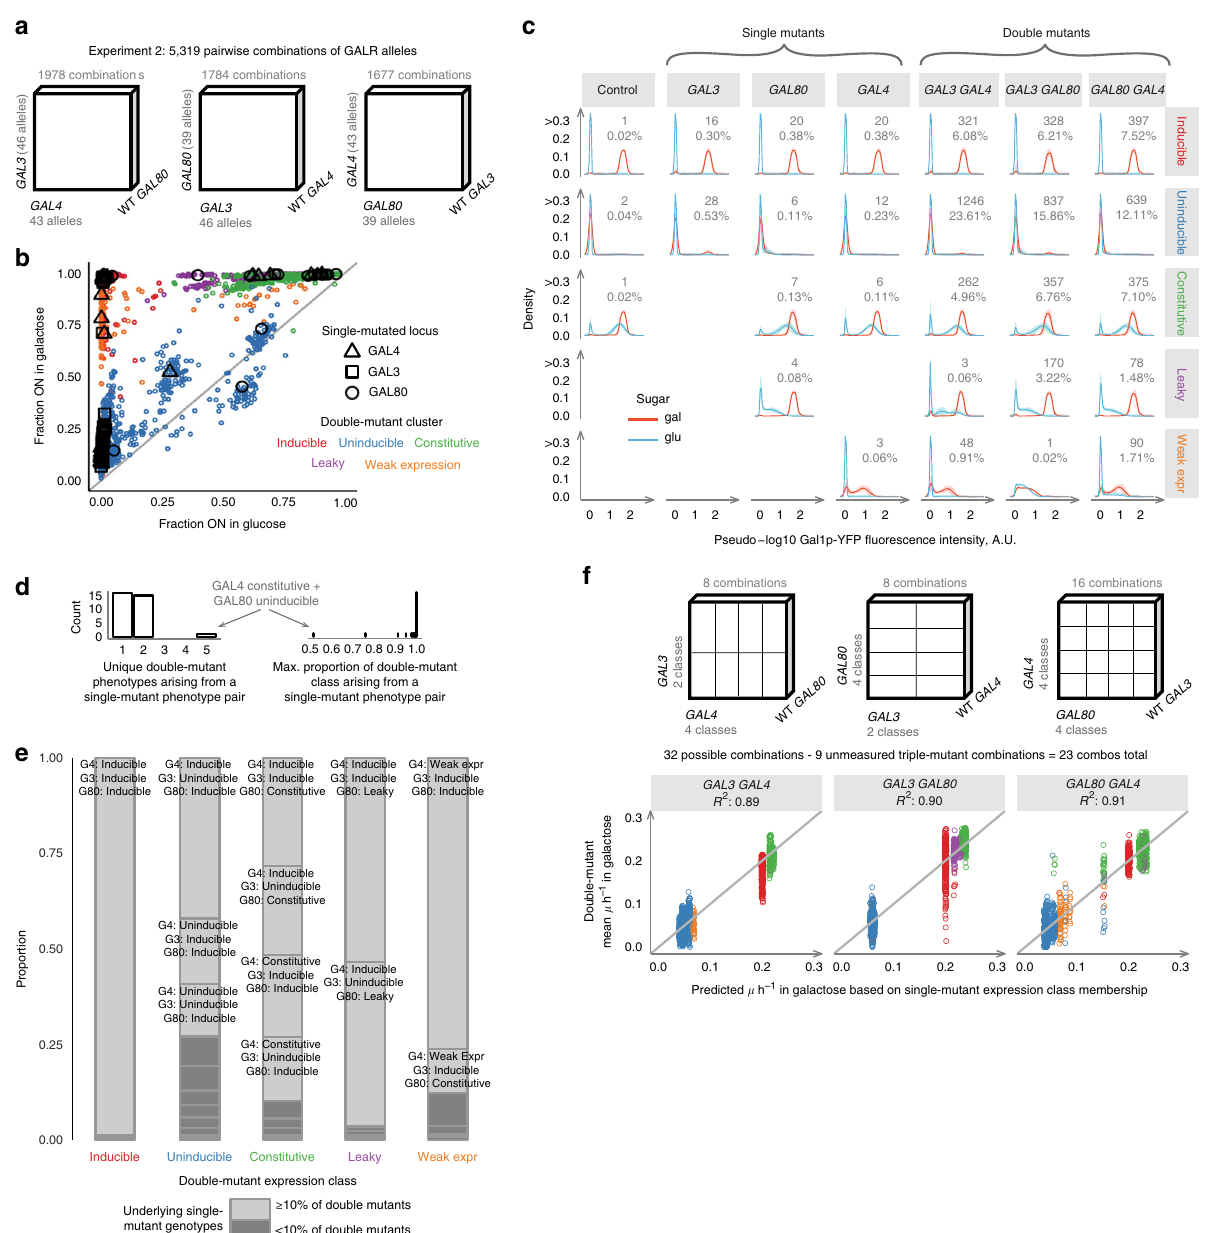
Fig. 2 Phenotypic variation from pairwise GALR allele combinations. a Alleles obtained by mutagenic PCR of a given GALR locus were paired with alleles of the other two loci. b Single and double mutants have more diverse phenotypes than gene deletions. Points represent the means of N = 2 to N = 36 (median N = 2) independent replicates across N = 1 to N = 18 independent transformants (median N = 1). Large black points are single mutants, with shape variation corresponding to the locus of the mutation, and small points are double mutants colored according to their resulting double-mutant phenotype. Gray line is X = Y . c Five classes of expression distributions. Lines and shaded regions are density means and ± 1 SD across genotypes of each class and genotype. Integers and percentages indicate the number of genotypes in each panel. d The count of unique double-mutant phenotype classes arising from single-mutant expression class combinations (left), and for each of these combinations, the proportion of pairings, which fell into the most prevalent class (right). e The single-mutant combinations, leading to a given double-mutant phenotype shown as stacked bar plots. Single-mutant combinations that comprised >10% of genotypes, leading to the indicated double-mutant phenotype are labeled on the chart. f The 23 mean growth rates corresponding to all pairwise combinations of single-mutant expression classes (horizontal axis) were used to predict 5152 double-mutant growth rates (vertical axis). for the three and fi ve expression class models, respectively. genes is, however, useful for making accurate predictions: three- Double-mutants arising from pairings between Constitutive and fi ve-class expression models that ignore the identity of the GAL4 alleles with Uninducible GAL80 alleles were the least mutated genes, respectively, explain 77% and 79% of the growth predictable in their resulting growth rates (Fig. 2d, points with rate variance, with large errors for particular class combinations growth predictions at ~0.15/h) and gene expression classes (Supplementary Fig. 5E, Methods). Thus, despite the strong (Supplementary Fig. 4). Knowing the identity of the mutated epistasis in this system, simple models that capture the main